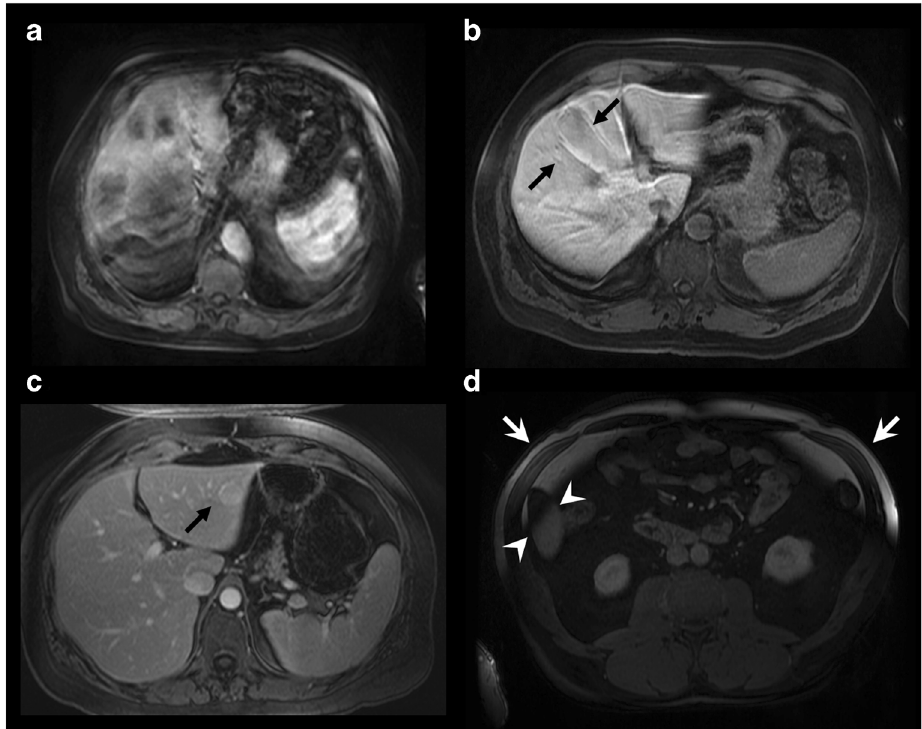
Fig. 13 Imaging pitfalls which may degrade liver segmentation on MRI. Axial T1-weighted fat- saturated images with contrast in- jection depict the following arte- facts: a Severe motion artefact. b Partial volume averaging of the liver parenchyma with the gall- bladder ( arrows ). c Ghost artefact with the aorta ( arrow ). d